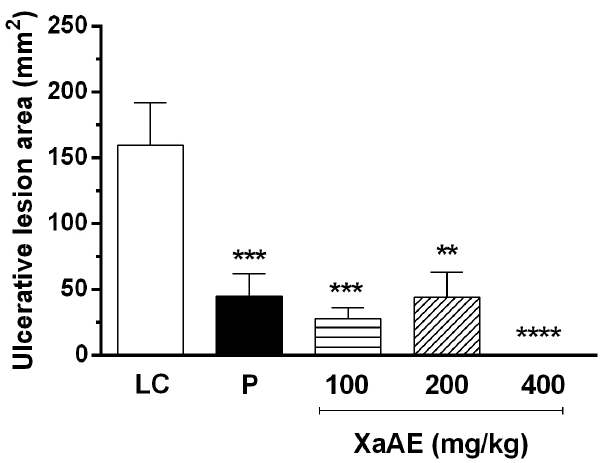
Figure 3. Gastroprotective effect of X. americana (XaAE) aqueous extract on absolute ethanol-induced (99%, 1 mL, orally) gastric lesions in Wistar rats. Animals received 0.9% NaCl solution (lesioned control, LC, 10 mL/kg, orally), pantoprazole (P, 40 mg/kg, orally) or XaAE (100, 200 and 400 mg/kg, orally). Results were expressed as mean ± SEM (6–7 animals/group). Statistically different when compared to the lesioned control group (analysis of variance—ANOVA, followed by Dunnett’s multiple comparisons test, ** p < 0.001, *** p < 0.0005, **** p <